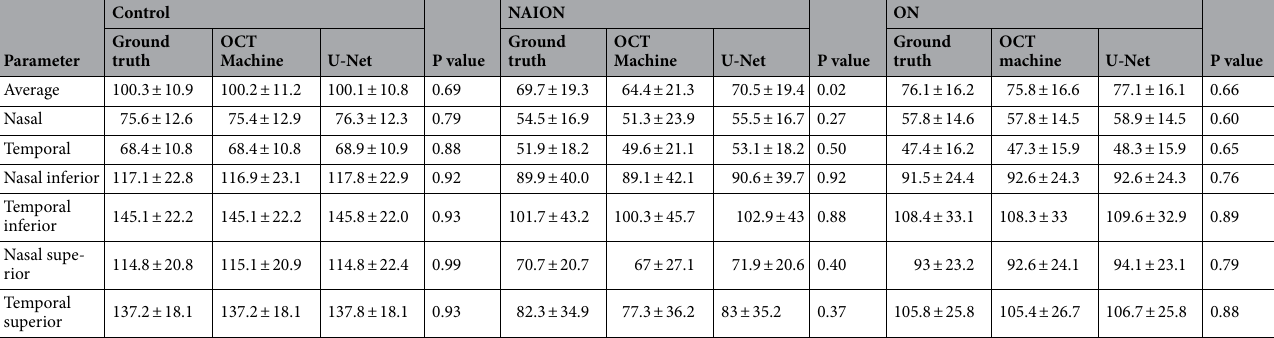
Table 1. Comparison of estimate of RNFL thickness measurements (µm) in seven sectors by three different methods in the control, non-arteritic anterior ischemic optic neuropathy (NAION) and demyelinating optic neuritis